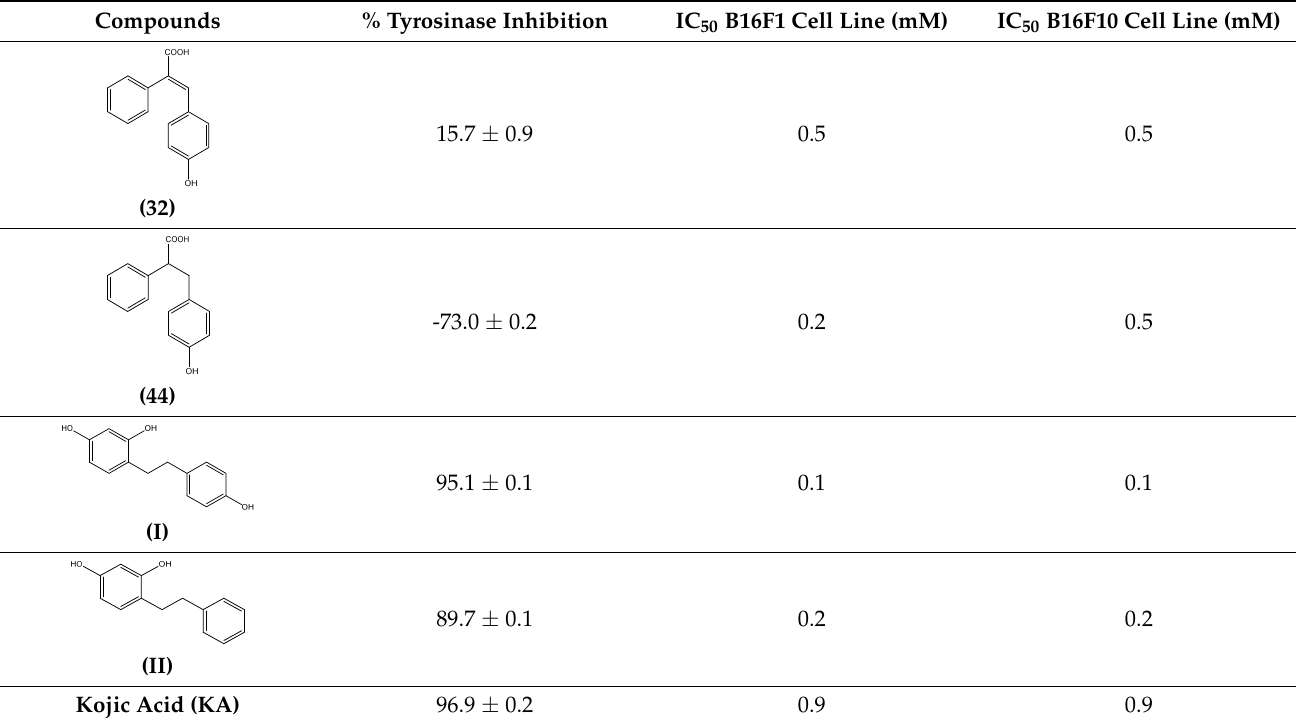
Figure 1. Stilbenoid and chalconoid analogues that were synthesized in the present work. Table 1. Tyrosinase % inhibition at 100 μΜ and their IC50 values in B16F10 and B16F1 melanoma cell lines.